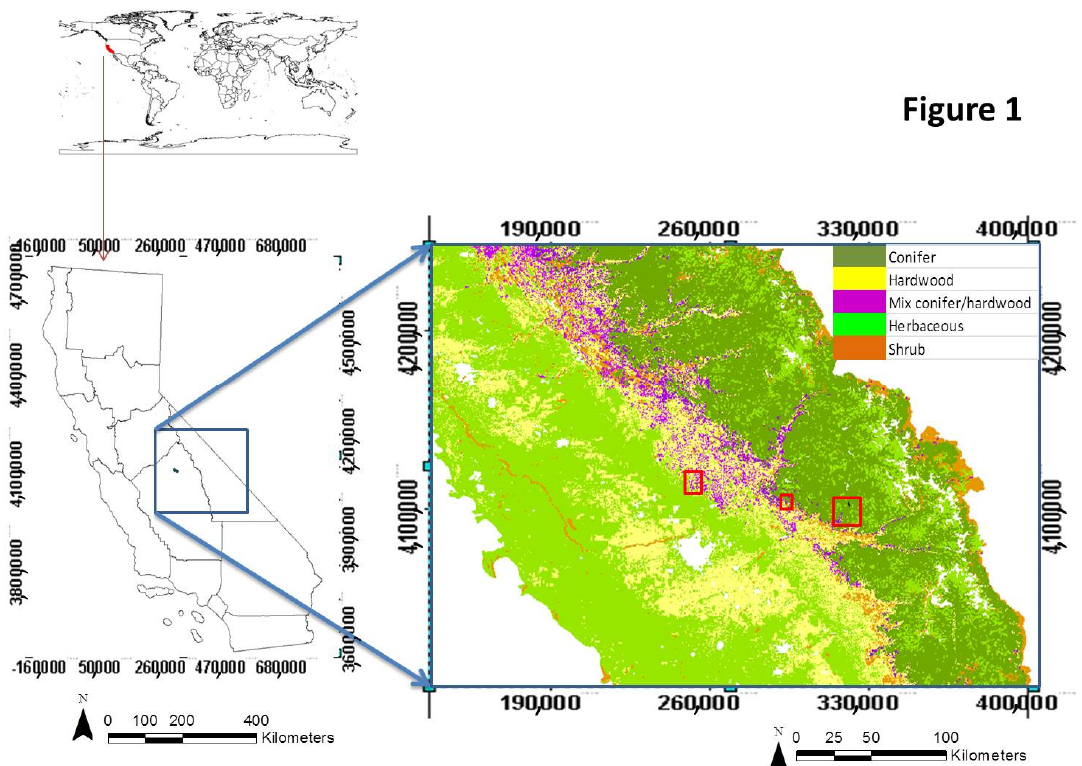
Figure 1. Maps of study region. Blue box shows the context of this data in California while the red boxes in the panel show the National Ecological Observatory Network (NEON) study sites we used. The source of the land cover map shown in the figure is from the vegetation map of California (CALVEG). The five vegetation types are representative of the entire Sierra Nevada Range and the four lower elevation types in the Coast Ranges to the west of the Central Valley of California.